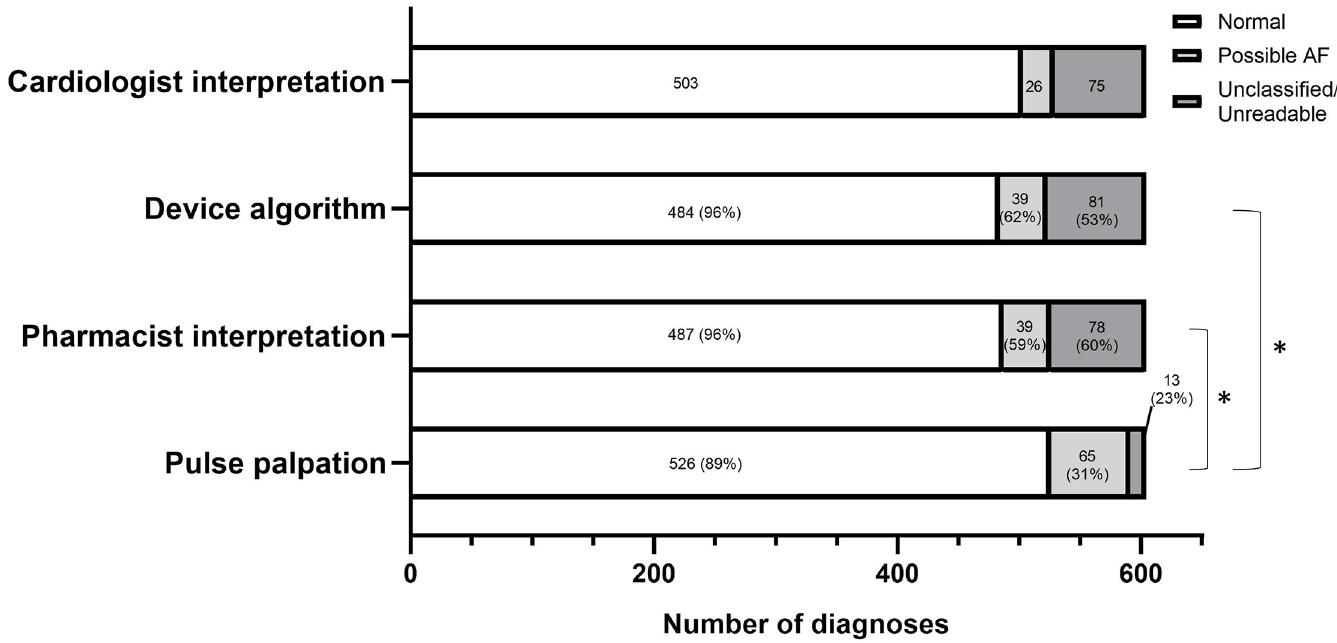
Fig 2. Screening for AF, measurement comparison. A breakdown of diagnoses derived from pulse palpation, KMD algorithm, and pharmacist interpretation of the SL ECG compared with the cardiologist’s interpretation of the SL ECG. All data are expressed as the number of cases in each diagnostic category (% diagnostic agreement with cardiologist diagnoses). � p = 0.001 for differences derived from 2 × 2 contingency tables for AF-positive and AF-negative diagnoses between KMD and pulse palpation and between pharmacist interpretation and pulse palpation. AF, atrial fibrillation; KMD, Kardia Mobile Device; SL ECG, single-lead ECG.